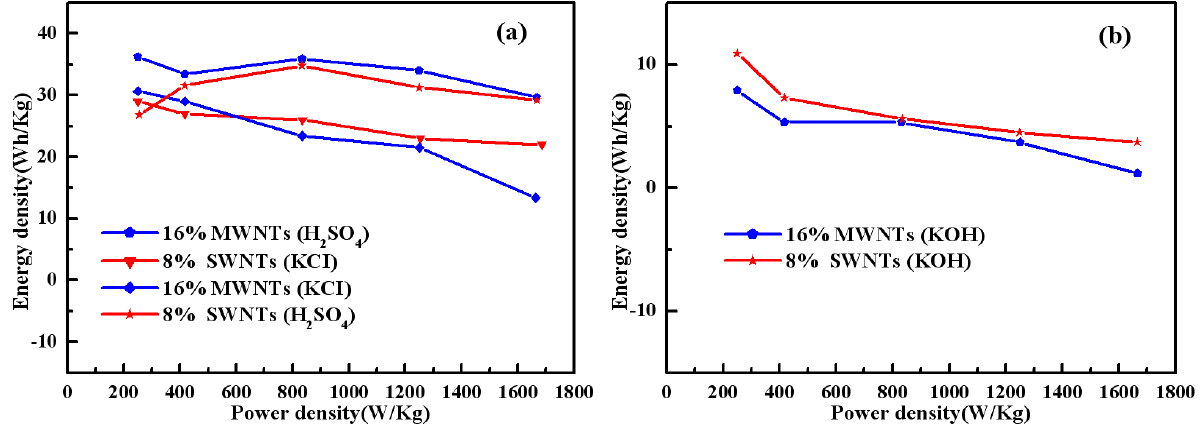
Figure 10. ( a ) Regone plots of specific power vs . specific energy for composites in 1 M H SO and in 1 M KCl; ( b ) Regone plots of specific power vs . specific energy for 2 4 composites in 6 M KOH.